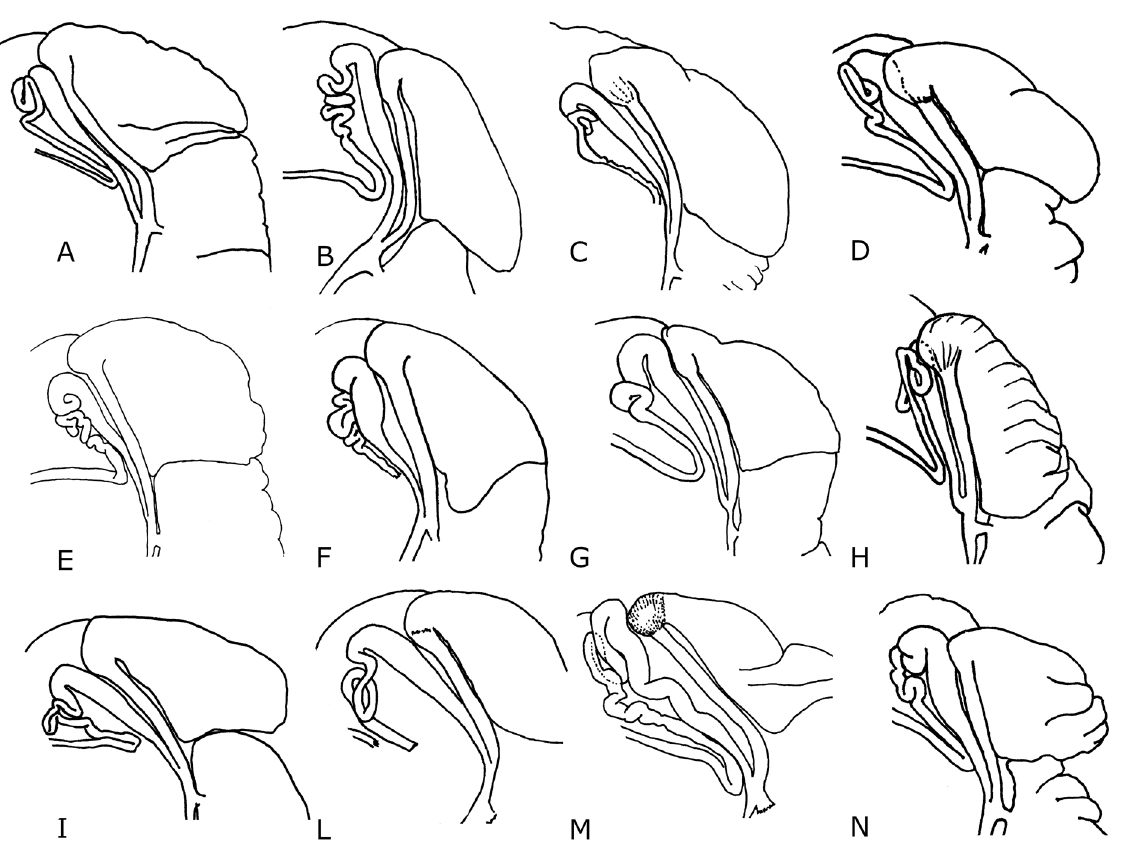
Fig. 29. Variation of the female genitalia in Cochlostoma ( Clessiniella ) tergestinum (Westerlund, 1878). A . Pri Cerkvi, Slovenia (WdM6834). B . Brestovica, Slovenia (WdM6948). C . Dobratsch, Austria (EZ0799). D . Goriansko, Slovenia (WdM6950). E . Prešnica, Slovenia (WdM6734). F . Farjev Vrh, Slovenia (WdM6740). G . Rasko Polje, Croatia (EZ0813). H . Rasa, Croatia (WdM6968). I . Permani, Croatia (WdM6708). L . Meja-Bakarac, Croatia (WdM6951). M . Jakačici, Croatia (WdM6699). N . Drivenik, Croatia